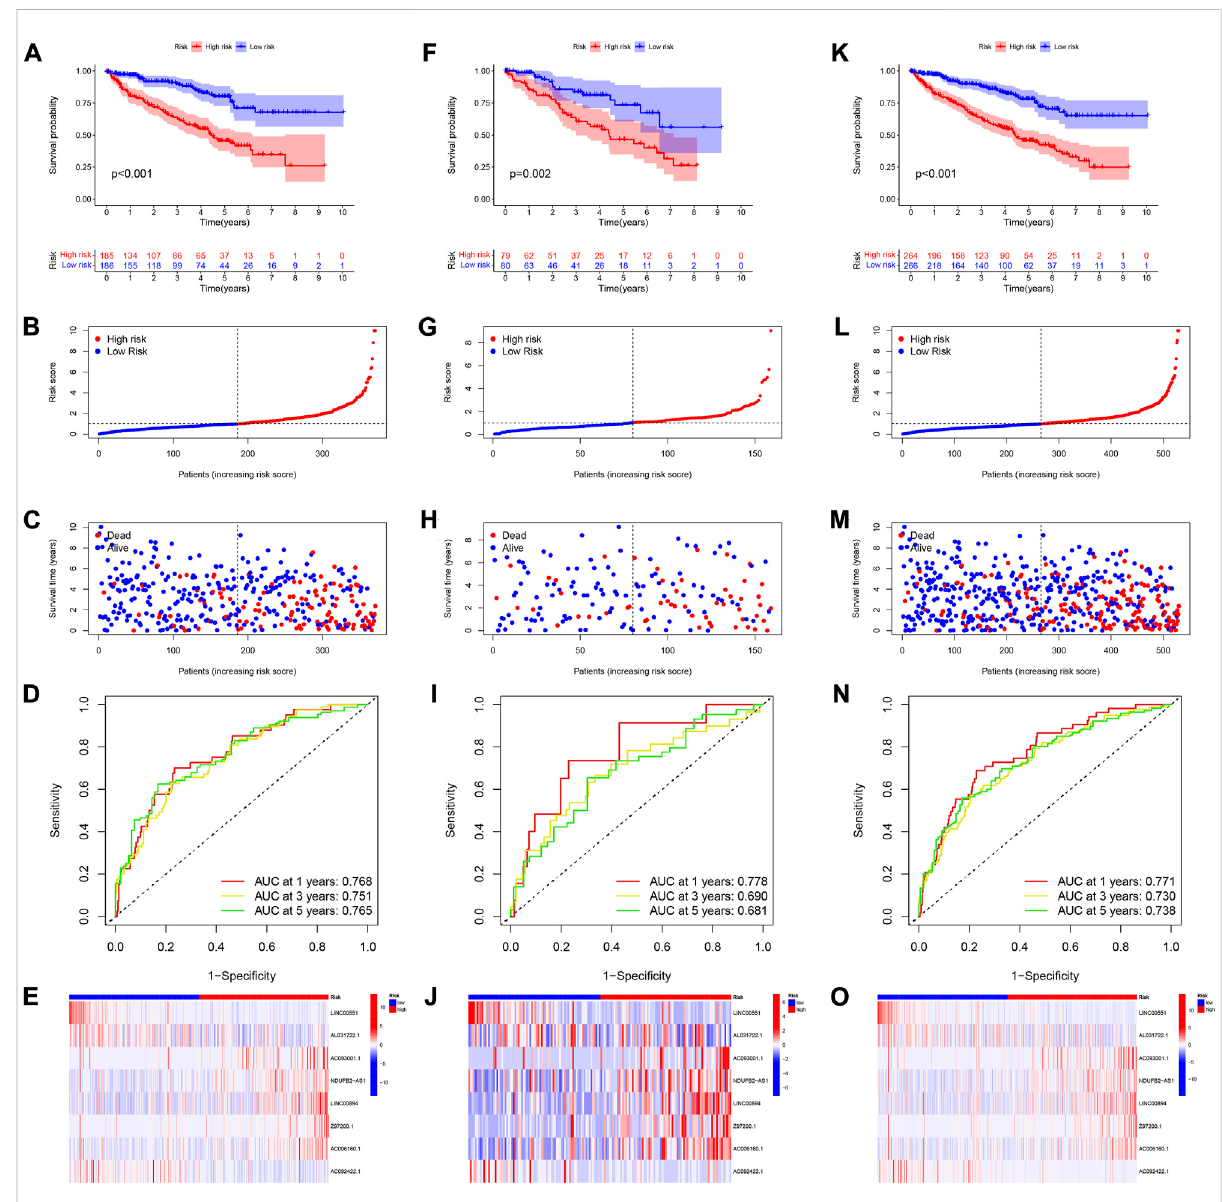
FIGURE 4 Veri fi cationof8CRlncRNAssignature. (A – E) KMsurvival,riskscore,1-,3-,and5-yearROCandheatmapsofaccordingtoCRlncRNAsgroupsin TCGA training set. (F – J) KM survival, risk score, 1-, 3-, and 5-year ROC and heatmaps of according to CRlncRNAs groups in TCGA testing set. (K – O) KM survival, risk score, 1-, 3-, and 5-year ROC and heatmaps of according to CRlncRNAs groups in the entire TCGA